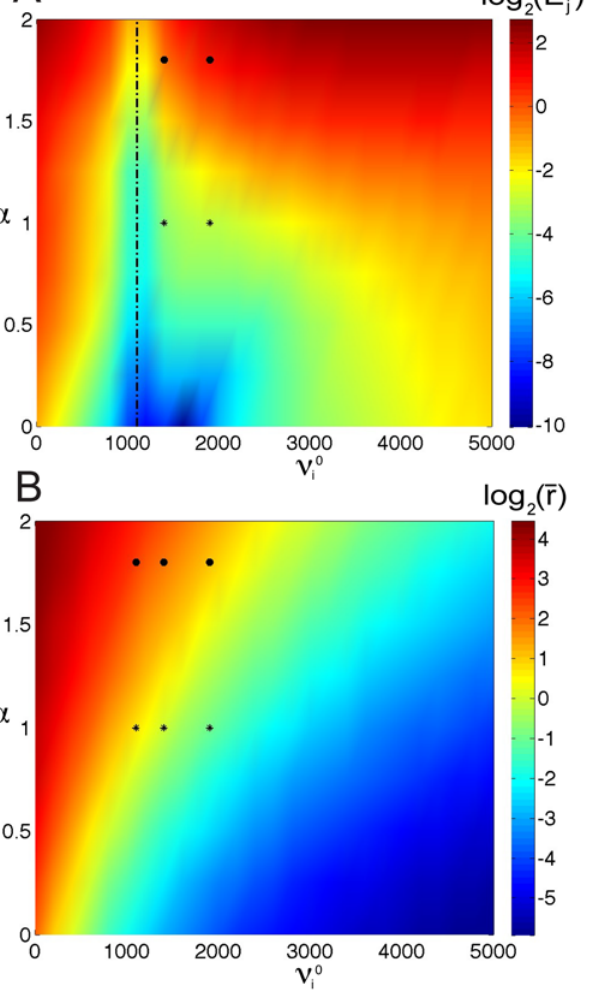
of the unscaled responses in Figure 3C, and the three black circles ( N ) at a ~ 1 : 8 are the average firing rates of the unscaled responses in Figure 5A (bottom panel). A logarthmic scale was used to better highlight the variety of